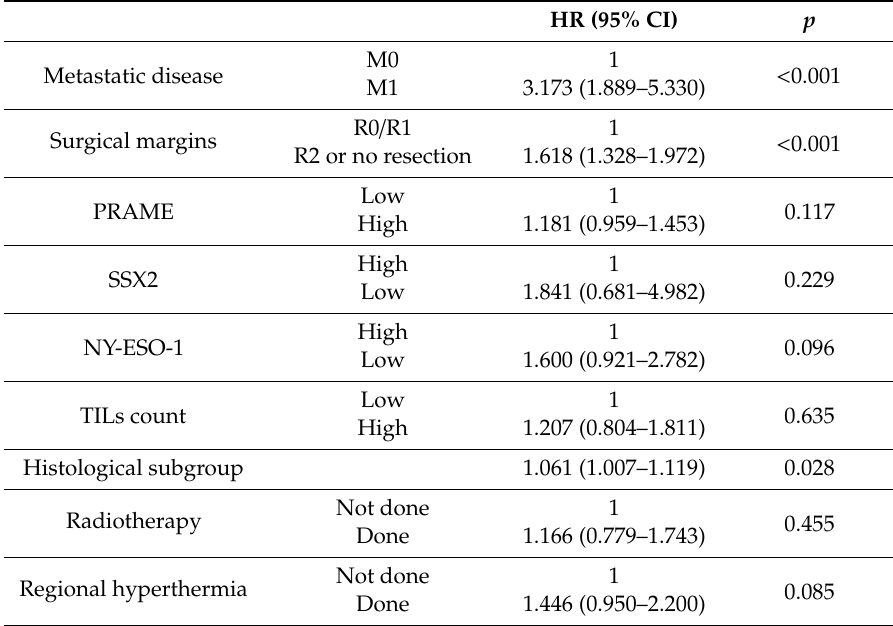
Table A2. Univariate analysis of risk factors for overall survival by Cox regression: HR, hazard